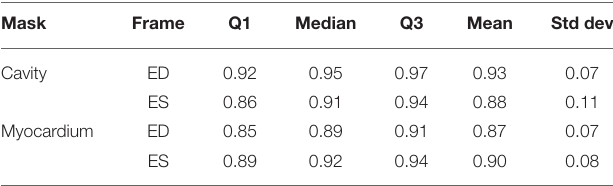
TABLE 4 | Dice score results of the segmentation network from the test dataset with 2,465 images.